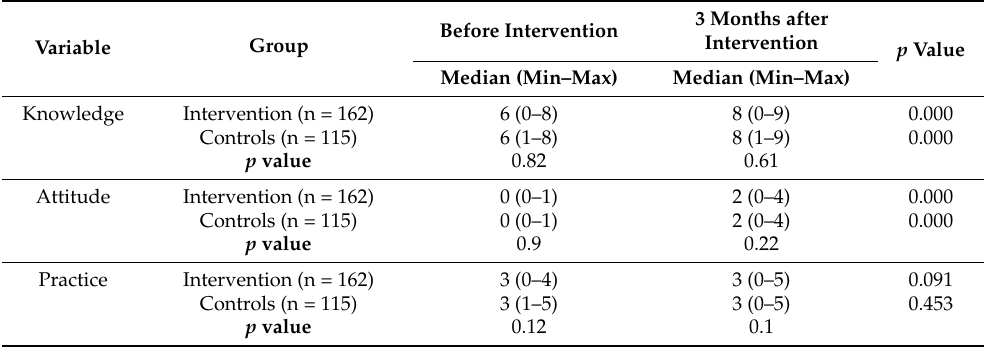
Table 2. Comparison of KAP between Control and Intervention